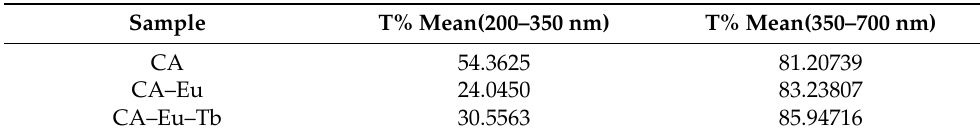
Table 1. Mean of the pure CA and light-conversion film for